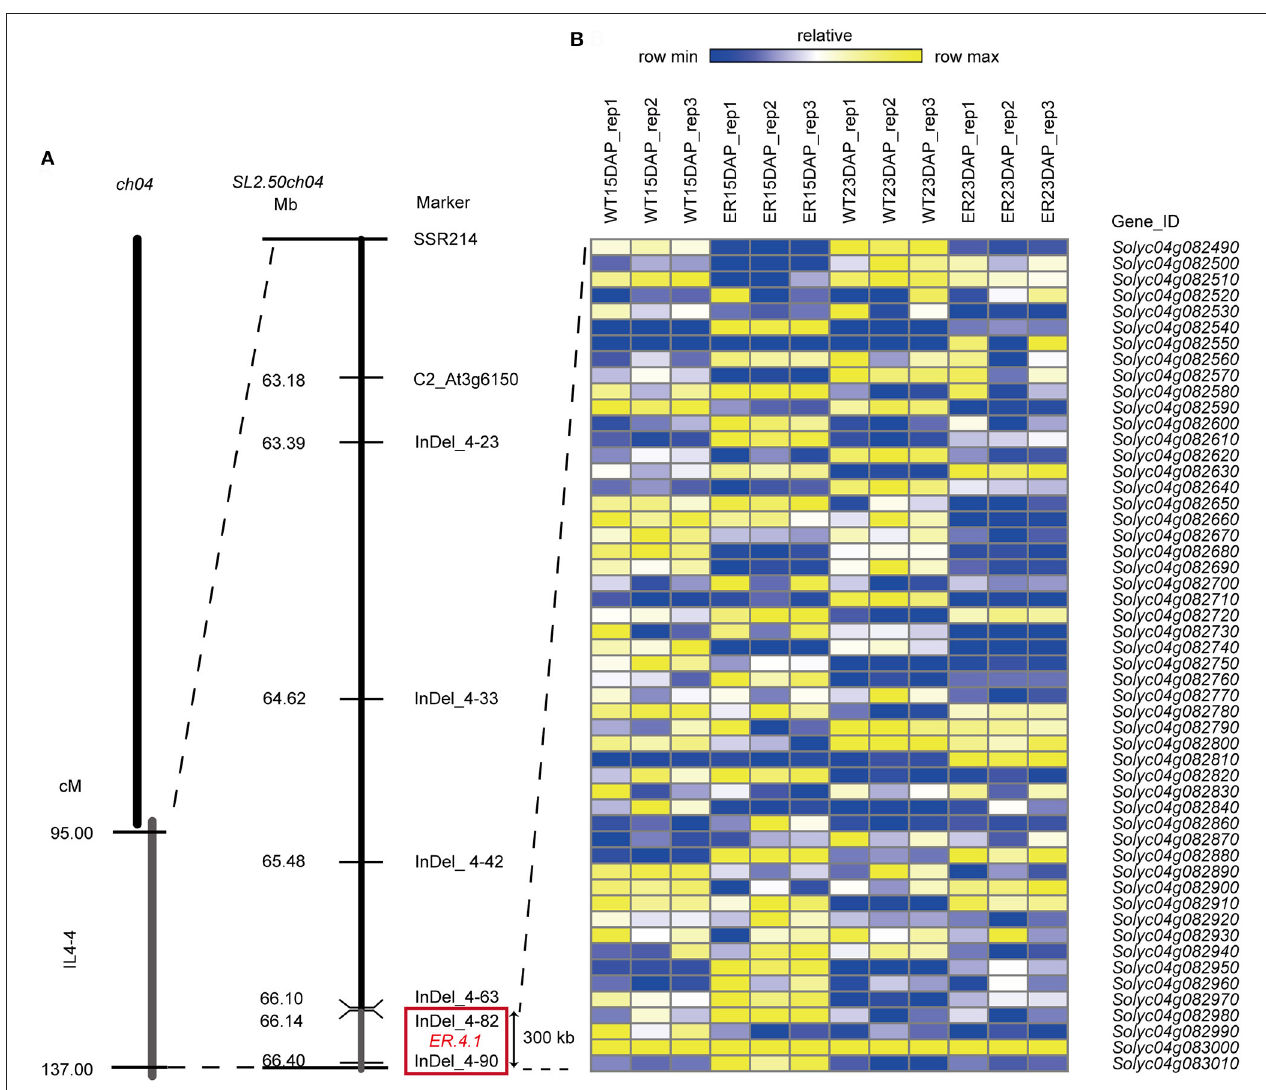
FIGURE 3 | Fine mapping of ER4.1 and analysis of candidate ER4.1 genes using RNA-seq data. (A) Fine mapping of ER4.1 using two BC 5 F 1 and BC 5 F 2 populations, mapped it to a ∼ 300 kb region flanked by InDel 4–82 and InDel 4–90. (B) The relative expression levels of 52 genes predicted to be located in this region at 15 days after pollination (DAP) and 23 DAP in epidermal reticulation ( ER) and WT fruit